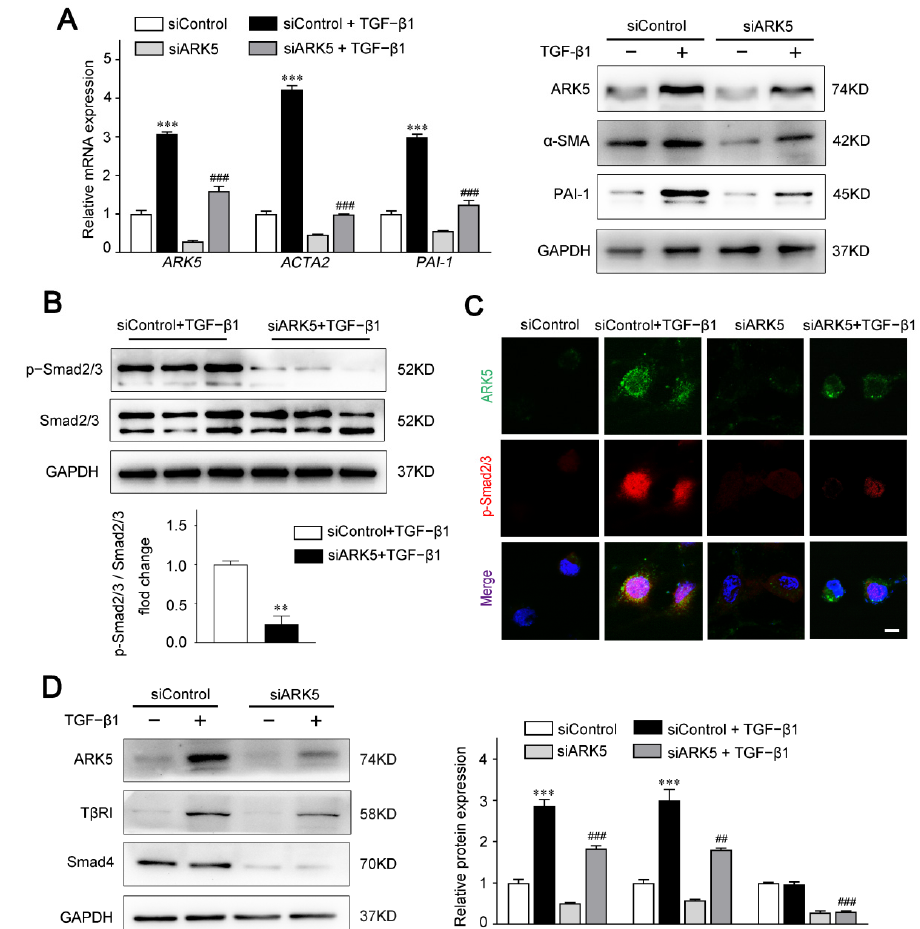
Figure 3. Knockdown of ARK5 expression attenuates the TGF- β -Smad2/3 signaling pathway. ( A ) Quantitative PCR and Western blot for ARK5 and fibrotic genes in control and